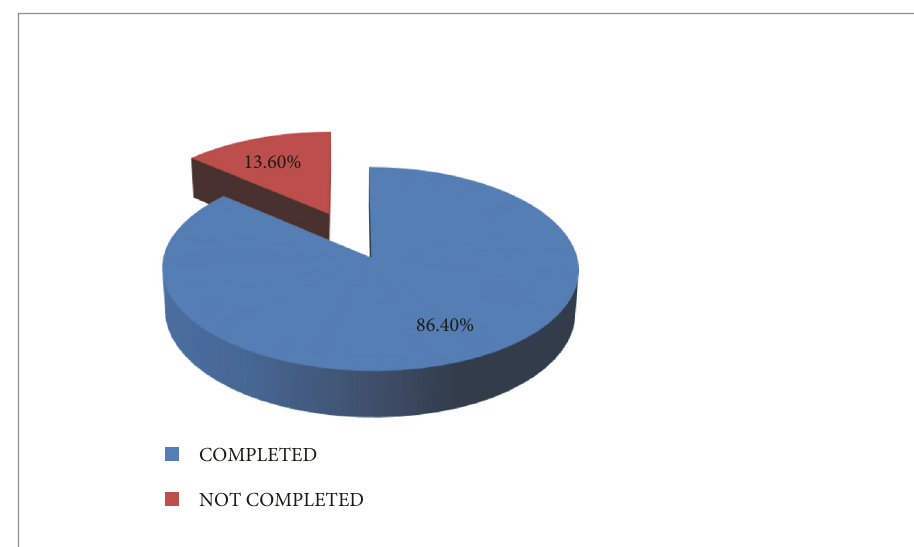
Figure 1: COMPLETION OF